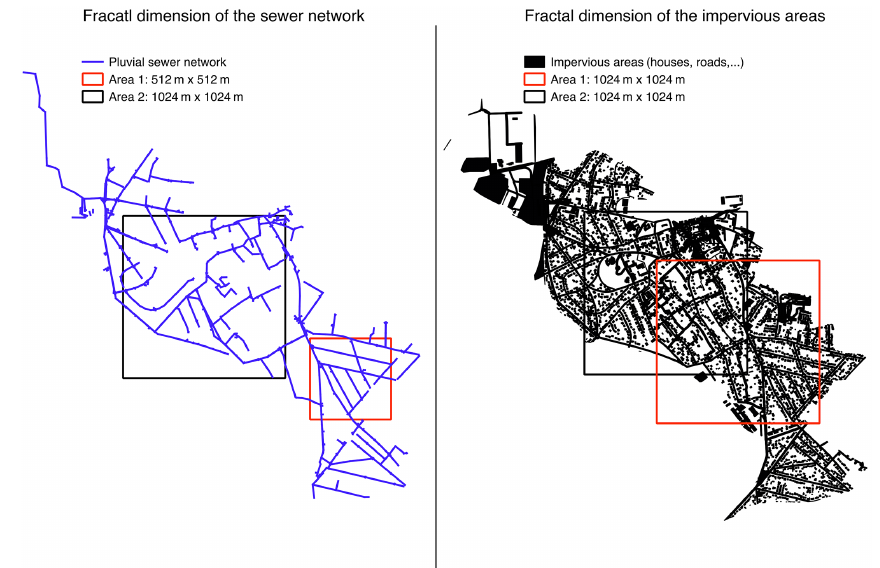
Figure 9. The original 2m pixel size data used to perform the fractal analysis of the storm water sewer system and impervious areas; two well-covered areas were selected.